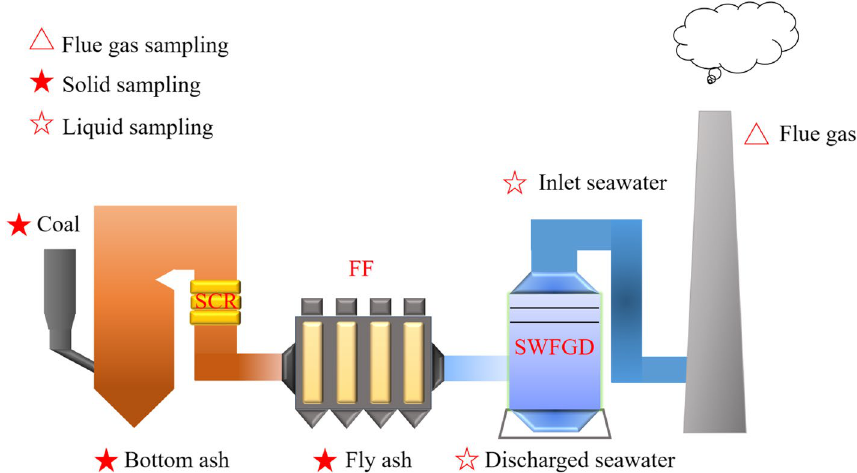
Fig. 1 Schematic of the APCDs and the sampling